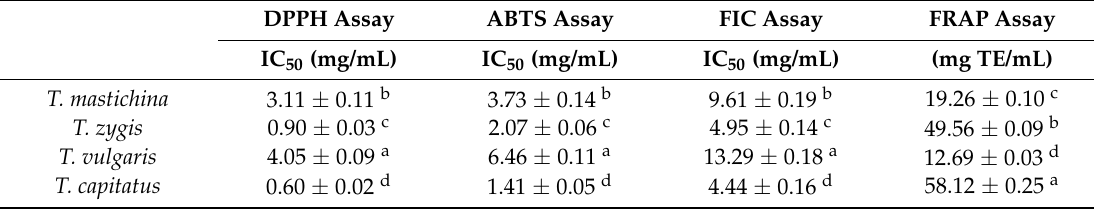
Table 1. Antioxidant activity of essential oils obtained from T. capitatus , T. mastichina , T. vulgaris and T. zygis determined using four different methods such as DPPH, ABTS, FRAP and FIC. DPPH